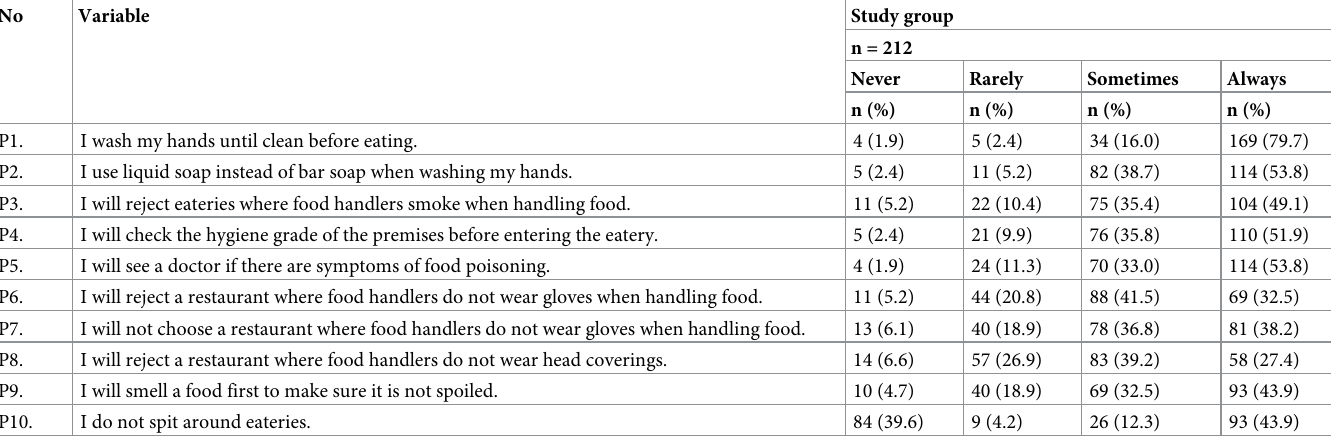
Table 15. Descriptive of preventive practice statements of food poisoning among